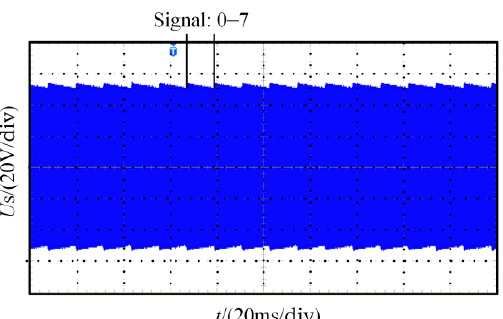
Figure 7. Receiving end voltage diagram of power and signal synchronous transmission